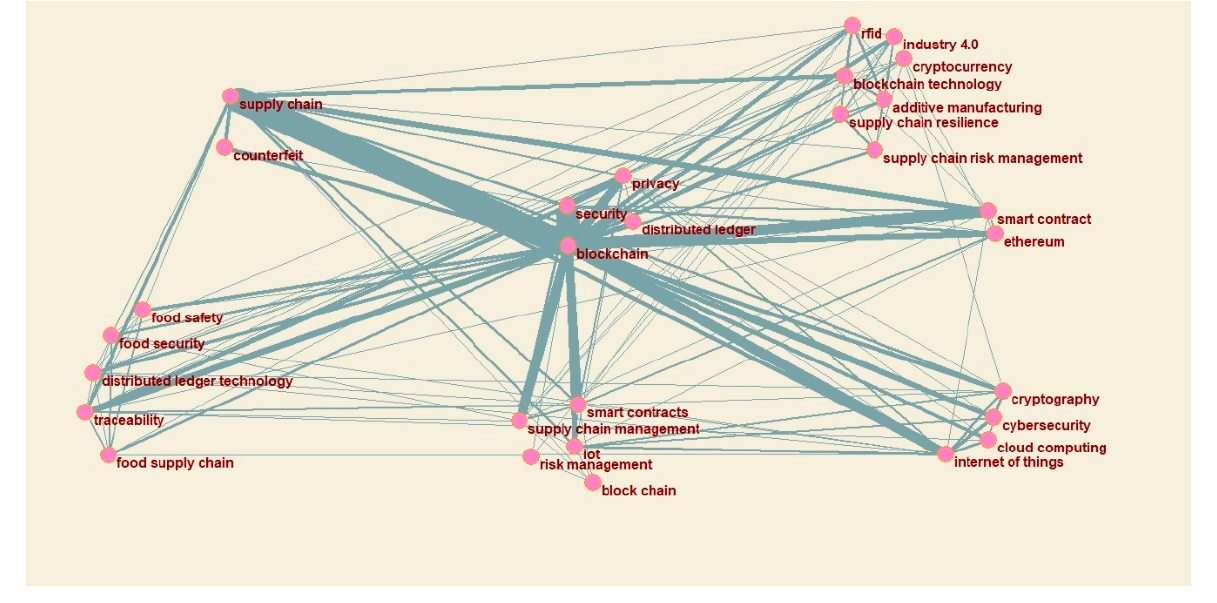
Figure 7. Authors keywords’ co-occurrence network. Table 3. Authors keywords’ co-occurrence